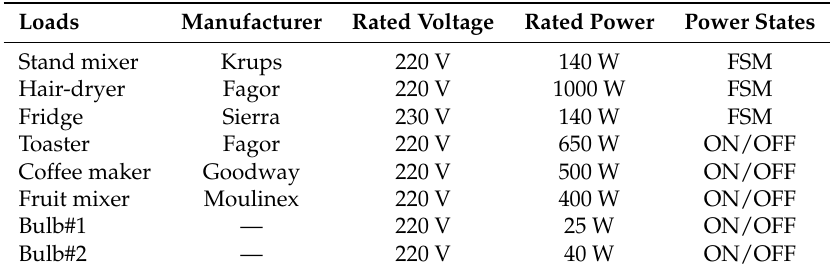
Table 4. Properties of recorded